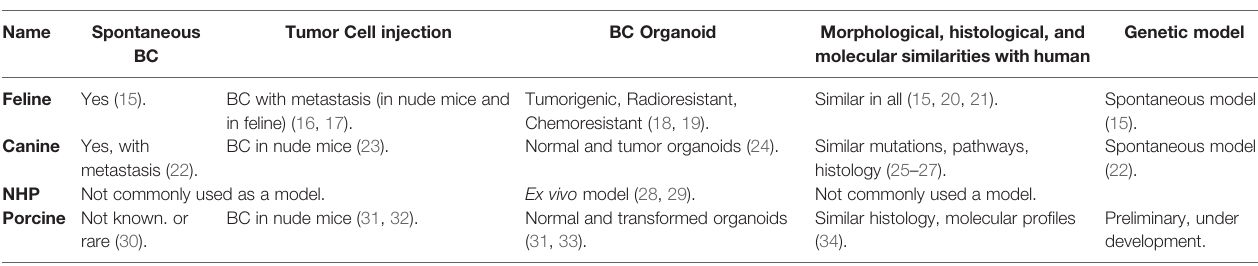
TABLE 2 | Current status of large animal models for BC.